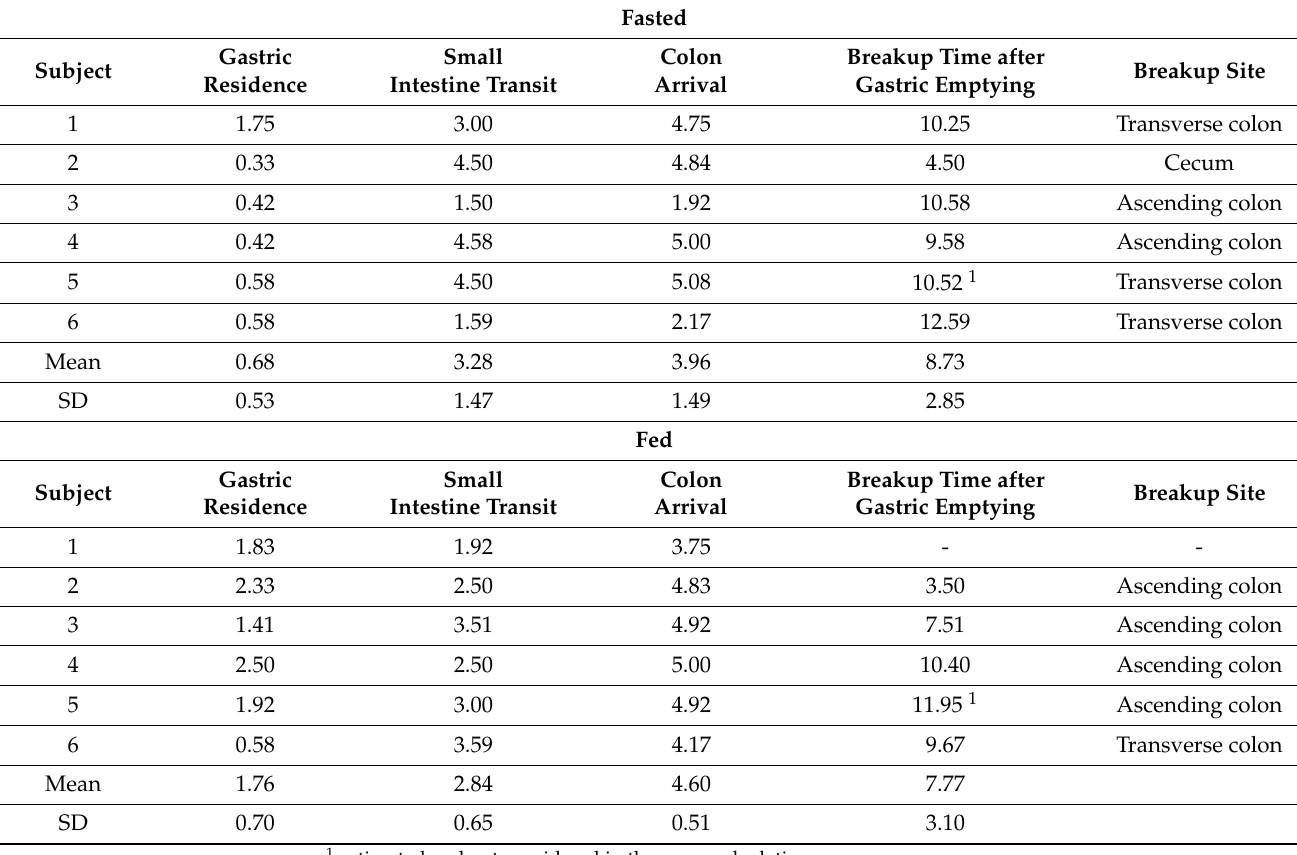
fasted volunteer (subject #2). The dashed portion of the curves indicates the 12 – 24 h time frame during which no experimental data were collected and does not reflect the actual time course of concentration. Red, yellow and green bars (bottom) indicate gastric, small intestinal and colonic residence, respectively; the blue bar (top) indicates disintegration. Reprinted with permission from Ref. [71]. 2019, Elsevier. Table 7. Transit and disintegration times (h) of double-coated 5-ASA Chronotopic ® systems (Metho- cel ® E50 applied to 50% weight gain) under fasted and fed conditions. Adapted with permission from Ref. [71]. 2019, Elsevier.